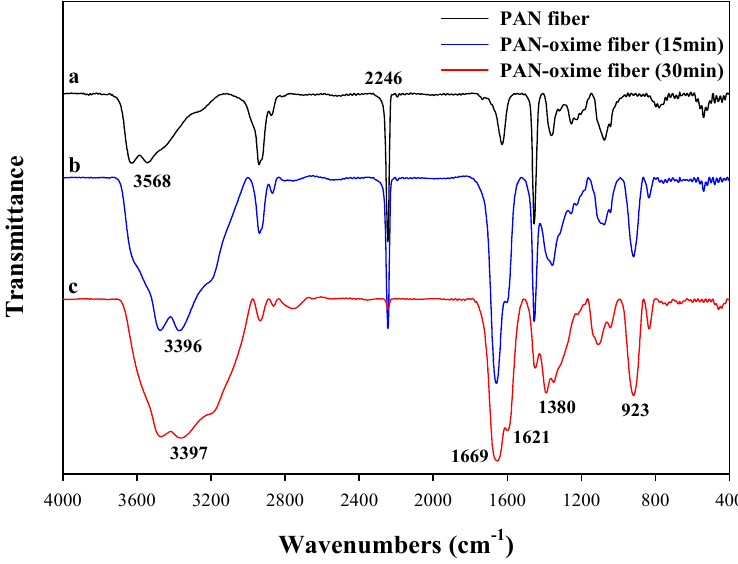
Figure 2. Fourier ‐ transform infrared (FT ‐ IR) spectra of PAN fiber and PAN–oxime fiber at different reaction times: ( a ) 0 min; ( b ) 15 min; and ( c ) 30 min.